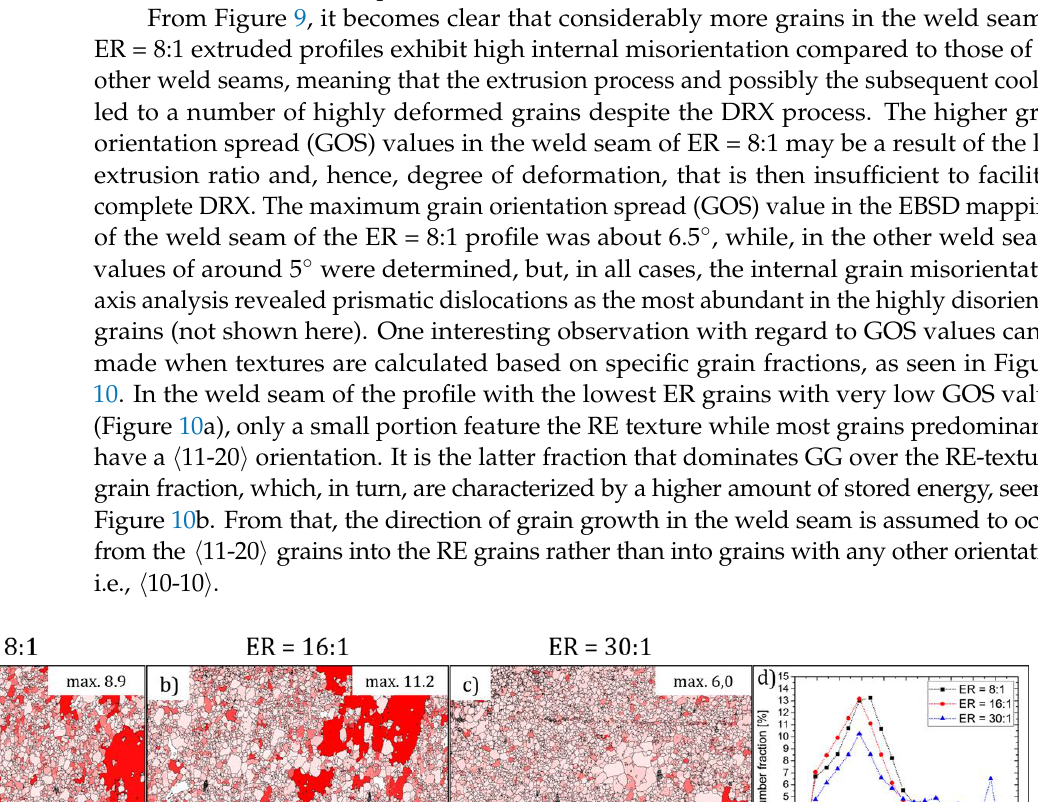
Figure 10. Development of misorientation distribution with increasing dwell time: ( a ) reference area, and ( b ) weld seam area. The fact that, in all cases, highly deformed grains exist but only in the weld seam of the lowest ER, a change in microstructure after heat treatment is observed, suggesting that a deformed grain alone cannot be responsible for the initiation of AGG, at least during short-time annealing. The recrystallized microstructure of RE containing alloys after hot deformation usually displays a peak around 30° in the misorientation angle distribution. All of the three weld seam microstructures feature such a peak but with different intensi- ties. There is also a remarkable difference in the fraction of boundaries with misorientation angles above and below 50°. Therefore, both weld seams with higher ERs display a higher fraction of >50° high angle boundaries than the weld seam of the lowest ER. It is assumed that those high angle grain boundaries (HAGB) are less mobile [24]. A rough estimate as the fraction of 30° boundaries decreases the fraction of HAGB increases with a growing overall strain. Furthermore, it is reported that 30° twist-and-tilt boundaries correspond to energy minima and are highly mobile [25].